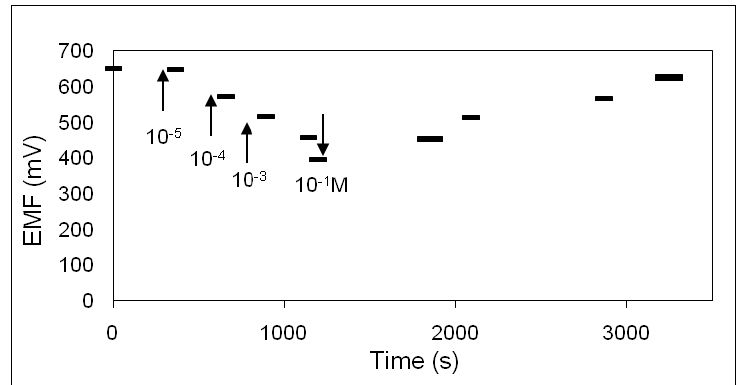
Figure 10. Dynamic potentiometric response to bromide and recovery time.